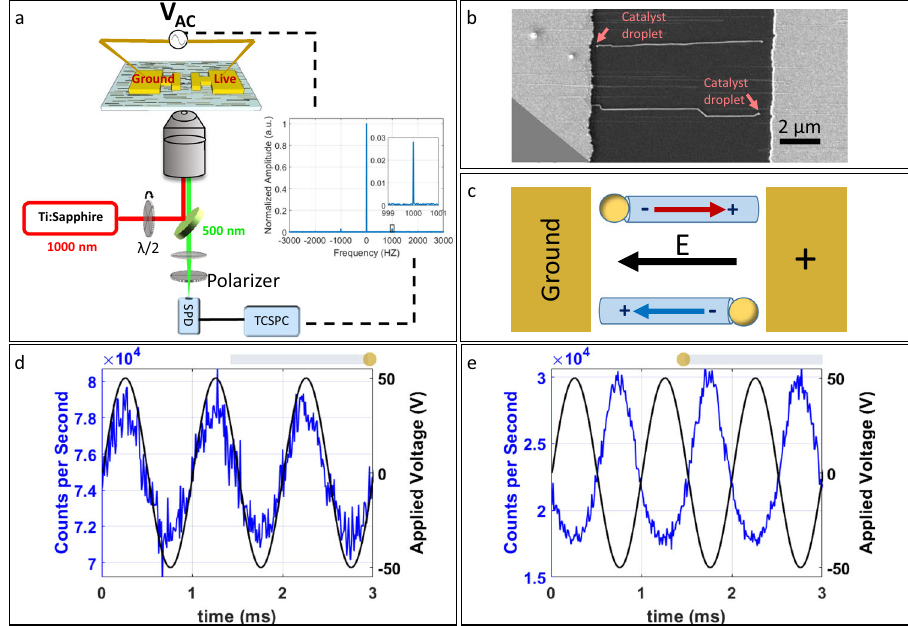
Fig. 2 Electric- fi eld-modulated SHG of nanowires with opposite growth directions. a Measurement scheme. 1000-nm laser is coupled into an inverted microscope and focused on a single nanowire lying between two electrodes. The SHG signal at 500 nm is collected by a single-photon detector (SPD) and time stamped using a time-correlated single-photon counting (TCSPC) system. A low-frequency (1 kHz) sine wave of various voltage amplitudes is applied. FFT spectrum of the SHG time trace collected while supplying the 1 kHz AC voltage. Inset: zoom in on the amplitude at 1 kHz. b SEM image of two nanowires with opposite growth directions between a pair of patterned electrodes. c A scheme of the con fi guration shown in ( b ). The red and blue arrows indicate the polarity of nanowires in opposite directions. d Applied AC voltage (black) and the time-averaged optical SHG signal (blue) from a right- growing nanowire and ( e ) a left-growing nanowire showing in-phase and anti-phase